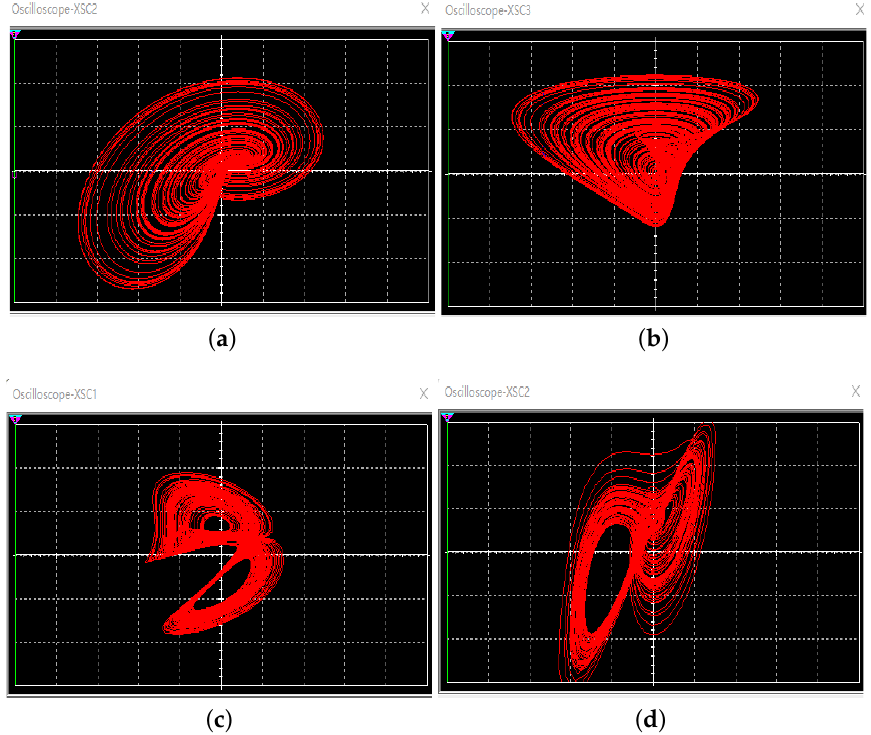
Figure 12. Phase spaces of the chaotic system (1) on an oscilloscope obtained from the analog circuit: ( a ) x-z; ( b ) y-z; ( c ) x-z; ( d )